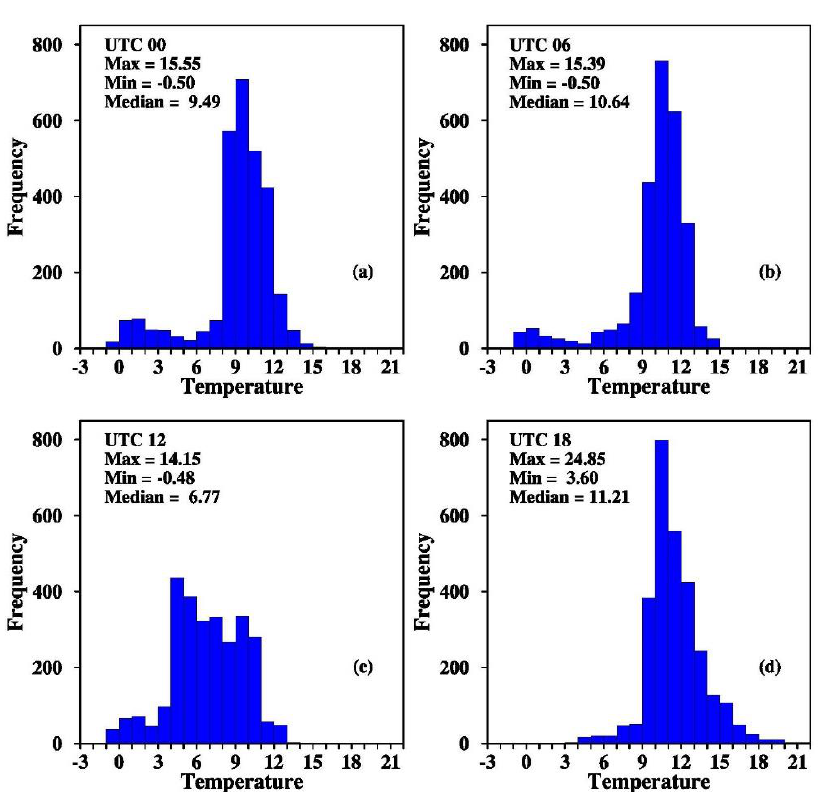
Figure 4. Average LST at different UTC times from GOES-E during the period of 2004–2009. Shown are the following cases: ( a ) UTC00; ( b ) UTC06; ( c ) UTC12; and ( d ) UTC18.